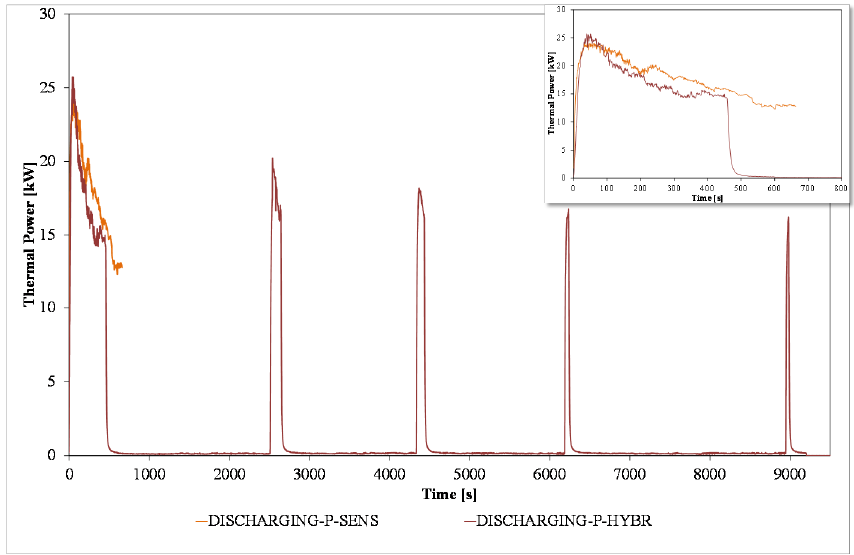
Figure 8. Comparison between discharging phases for both TES configurations at 12 kg/min, starting from 70 °C. Dynamic evolution of the discharging power measured. On the top-right corner is a detail of the time frame during which the sensible storage is fully discharged.